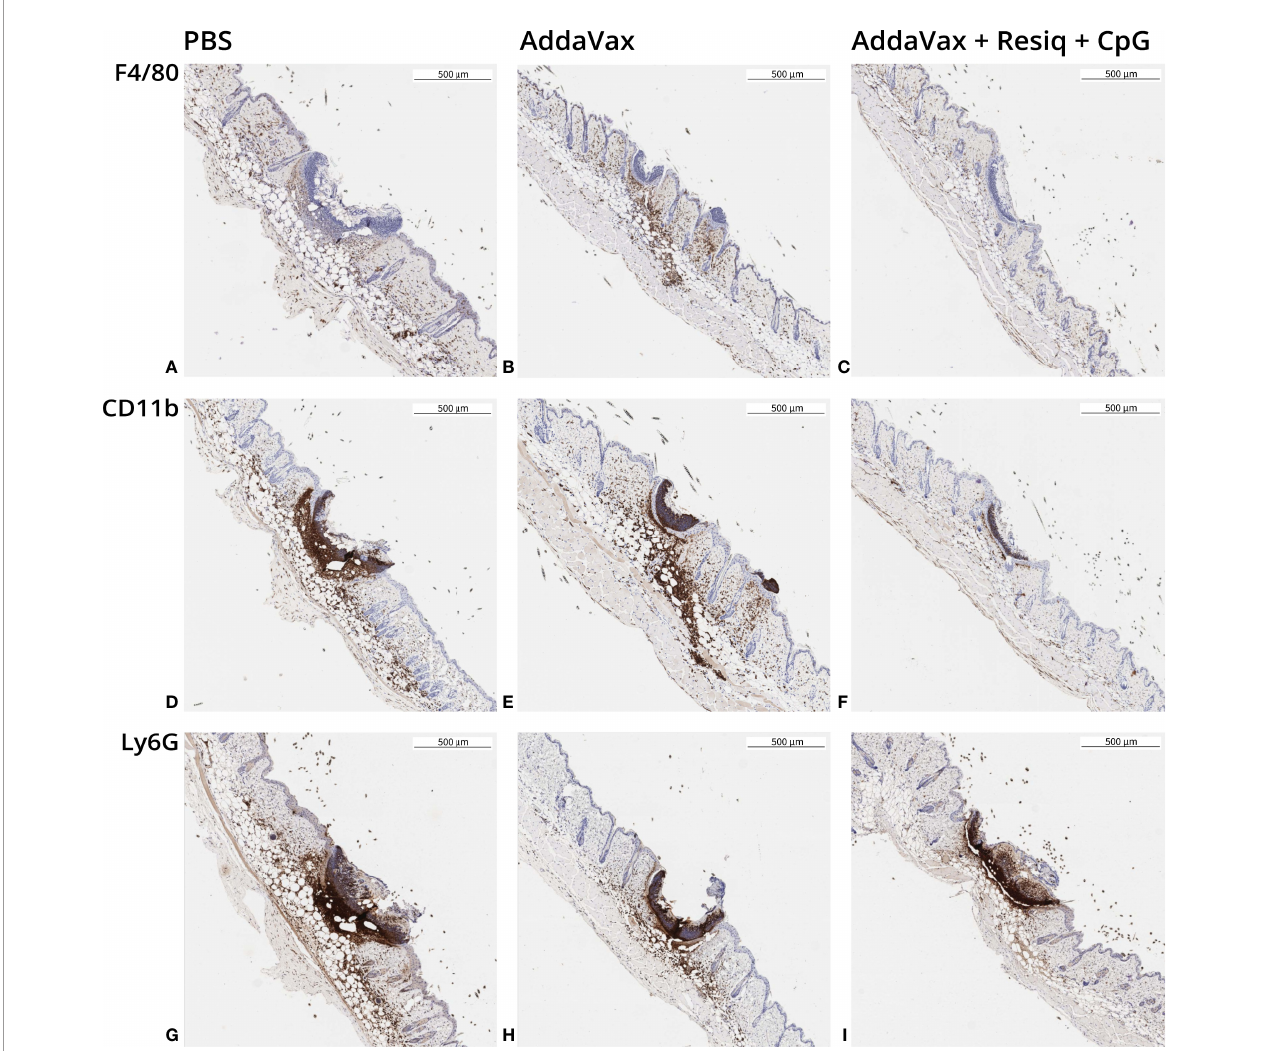
FIGURE 3 | Immunohistochemistry (IHC) of dorsal skin obtained 24h post SS prime. Skin sections were obtained from 2-3 mice/experimental group at 24h post SS with CS peptide in PBS ( fi rst column), Addavax (second column) or Addavax + Resiquimod + CpG (third column). Cellular in fi ltration was assessed in skin sections from SS site labeled by IHC with antibody to F4/80 (A – C) , CD11b (D – F) or Ly6G (G – I) . Similar results were obtained in three experiments with results of a representative experiment